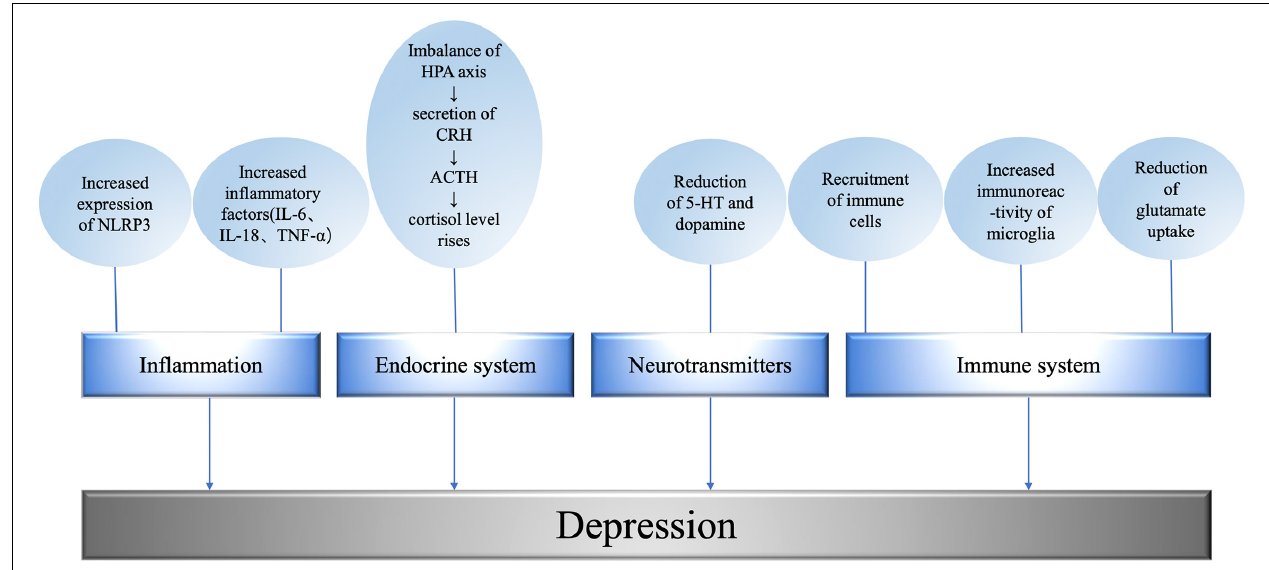
FIGURE 2 | Mechanism underlying metabolism related depression. The level of promoting factors is related to the degree of depression; the imbalance of HPA axis leads to the abnormality of endocrine system; excitatory neurotransmitters regulate depressive behavior; the immune system affects the occurrence of depression at the cellular and molecular level. NLRP3, NOD-like receptor protein 3; IL, interleukin; TNF, tumor necrosis factor; HPA, hypothalamic-pituitary-adrenal axis; CRH, corticotropin releasing hormone; ACTH, adrenocorticotropic hormone; 5-HT,